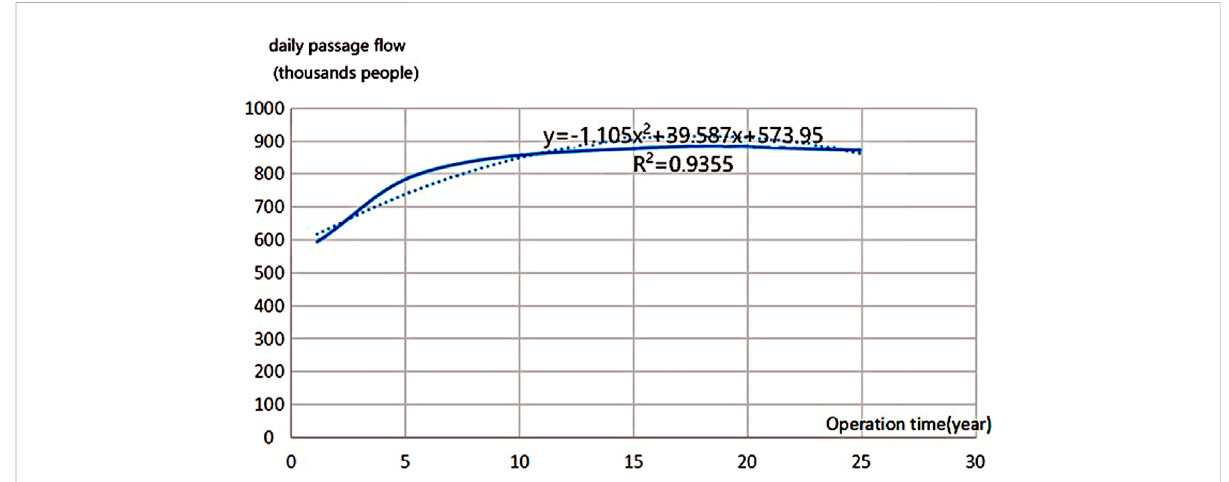
FIGURE 3 Prediction (solid line) and fi tting (dotted line) curves of Beijing Metro Line 4 passenger fl ow.